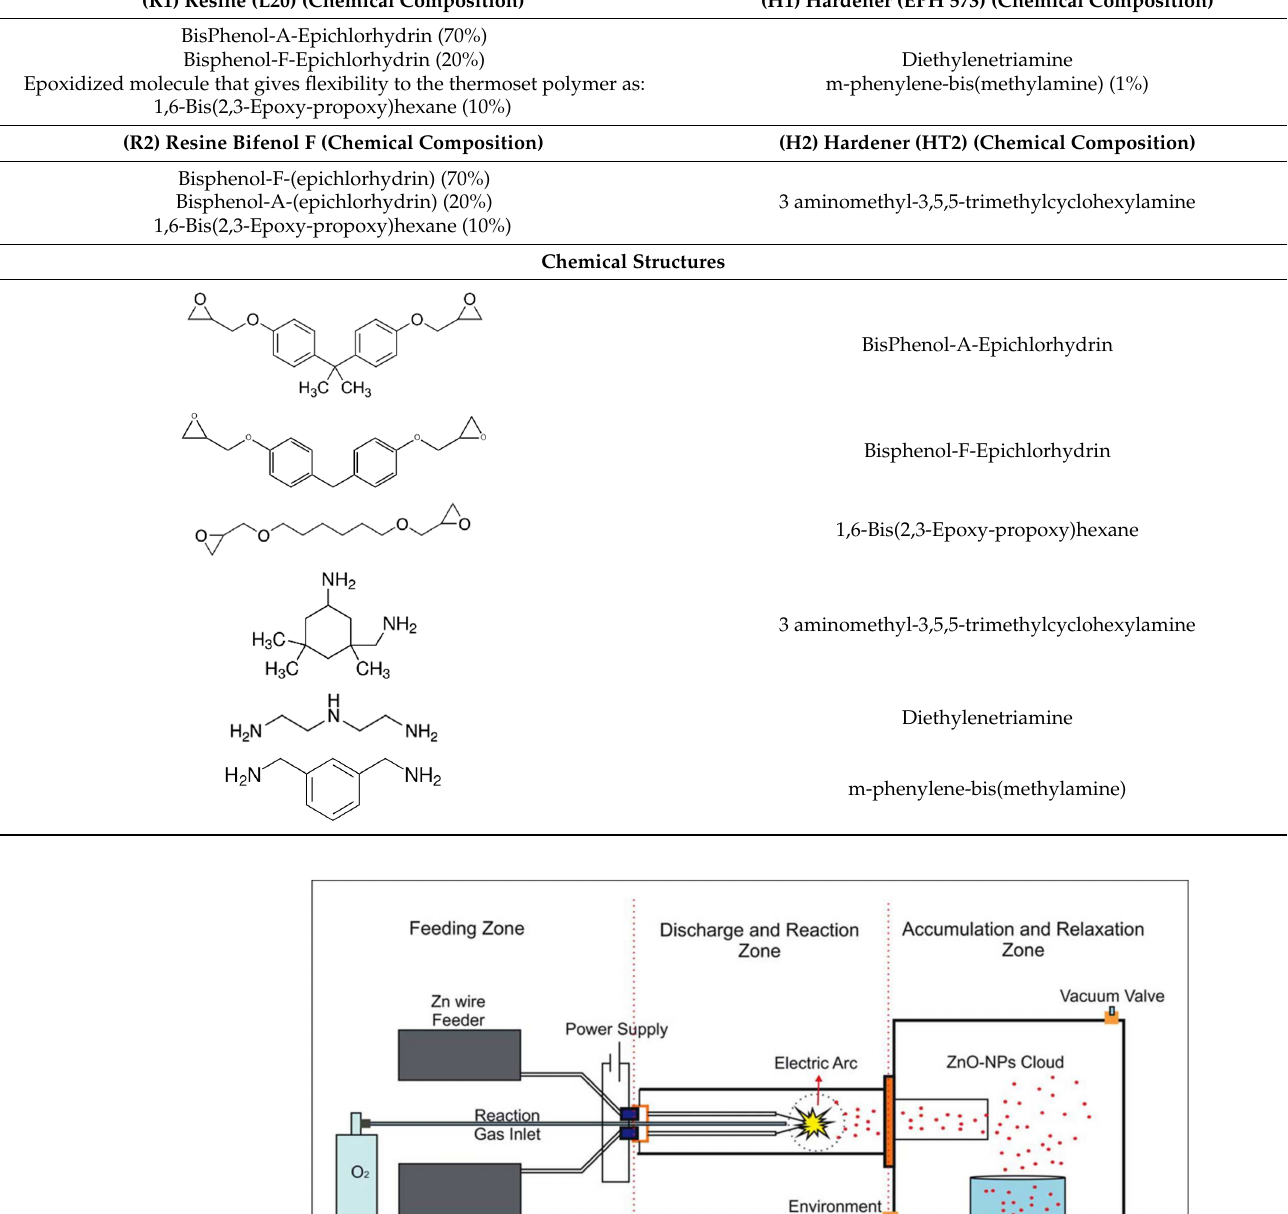
Table 1. Composition of the resins and hardeners used. (R1) Resine (L20) (Chemical Composition) (H1) Hardener (EPH 573) (Chemical Composition) Epoxidized molecule that gives flexibility to the thermoset polymer as: (R2) Resine Bifenol F (chemical composi-